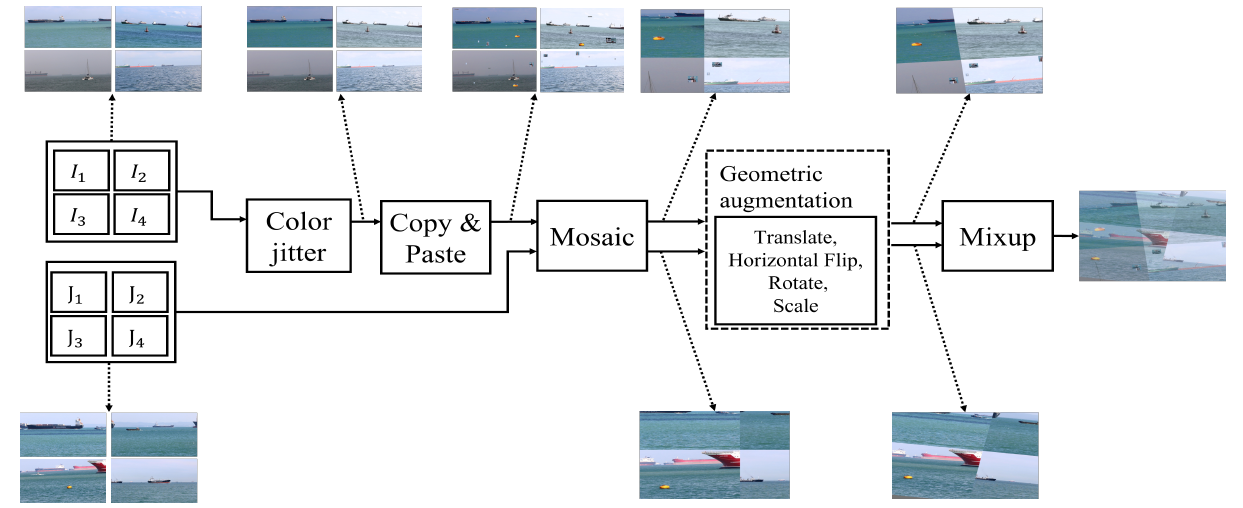
Figure 5. Flow of image augmentations for our YOLO-V5.